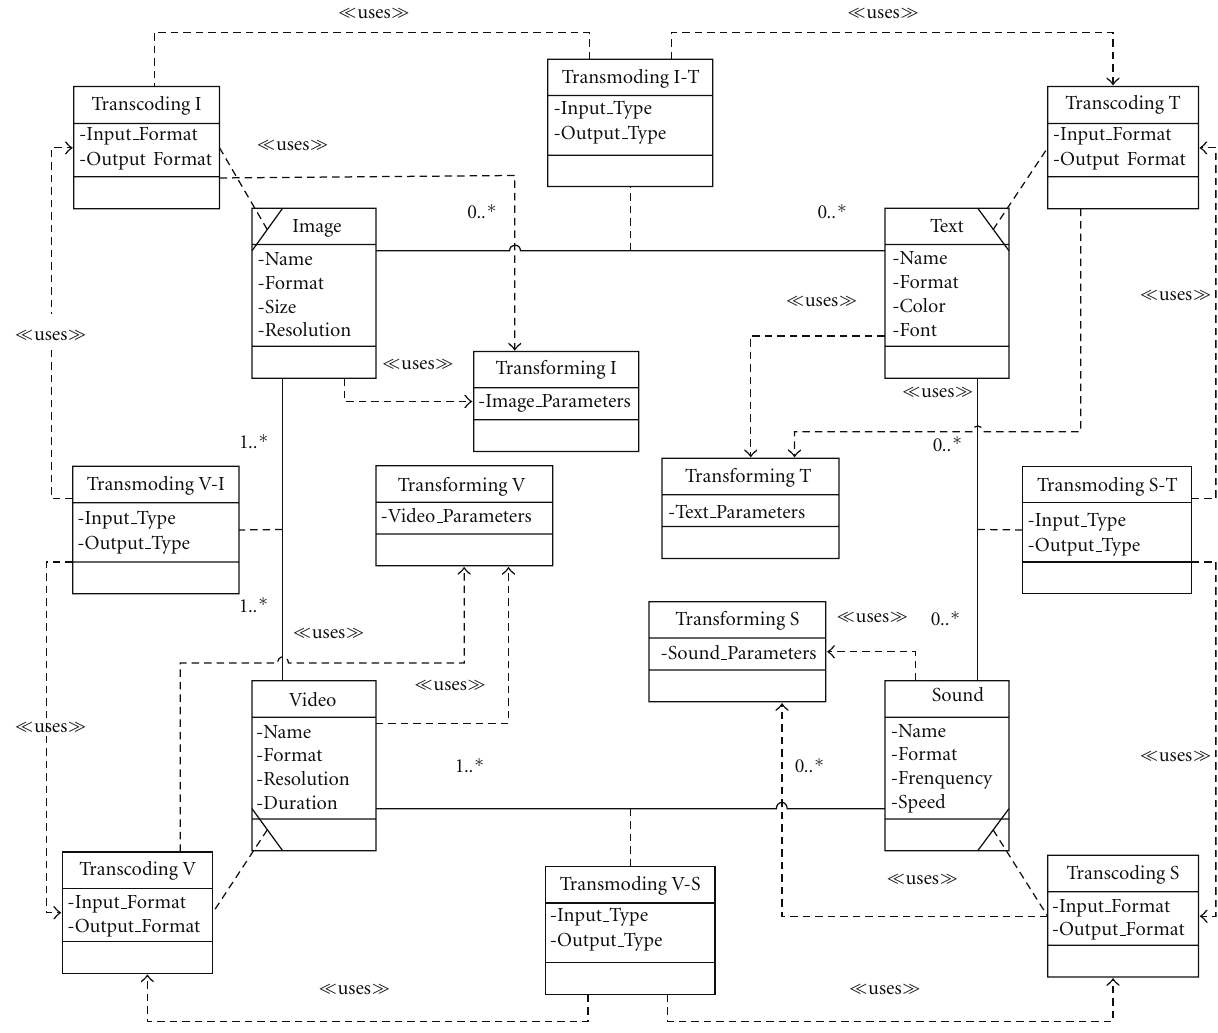
Figure 2: The transformation relationship between di ff erent